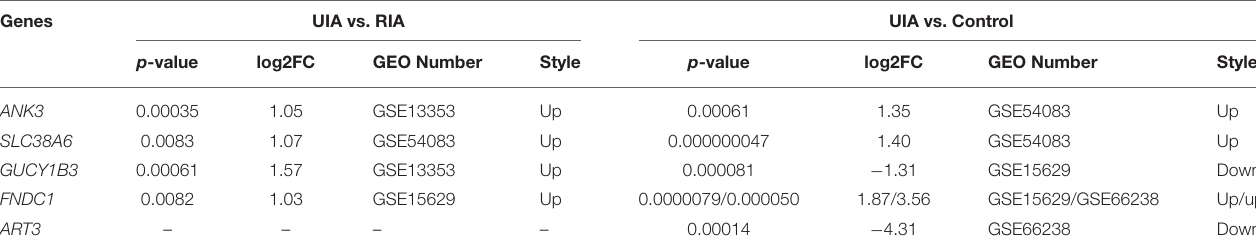
TABLE 4 | Venn analysis of differently expressed genes shared in GEO Databases and our study. Genes UIA vs. RIA UIA vs. Control p -value log2FC GEO